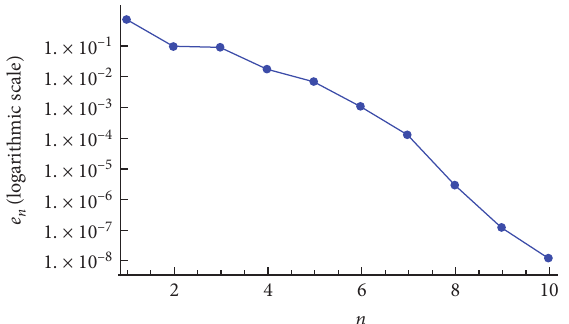
Figure 9: e n on logarithmic scale for